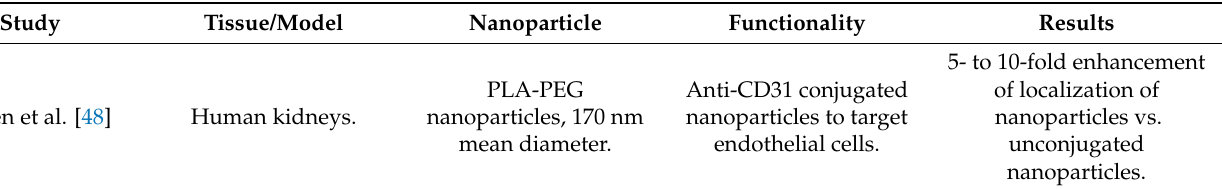
Table 1. Summary of representative literature for nanoparticle-based tolerance induction in various transplant